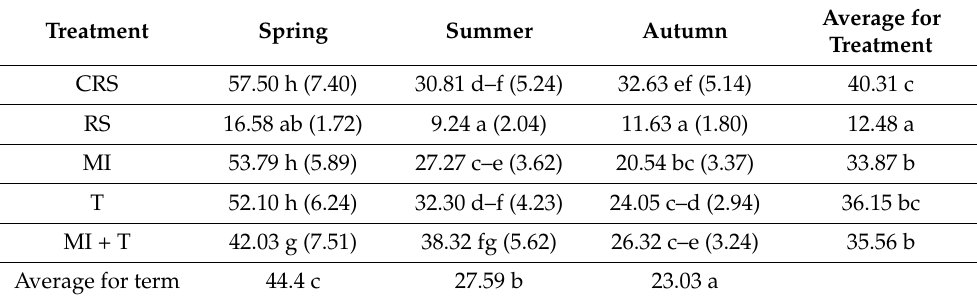
Table 4. Soil respiratory activity (mg CO 2 kg − 1 48 h − 1 ) in the years 2015–2016 (CRS = crop rotation soil; RS = replanted soil; MI = mycorrhizal inoculum; T = Trichoderma ; MI + T = mycorrhizal inoculum + Trivhoderma